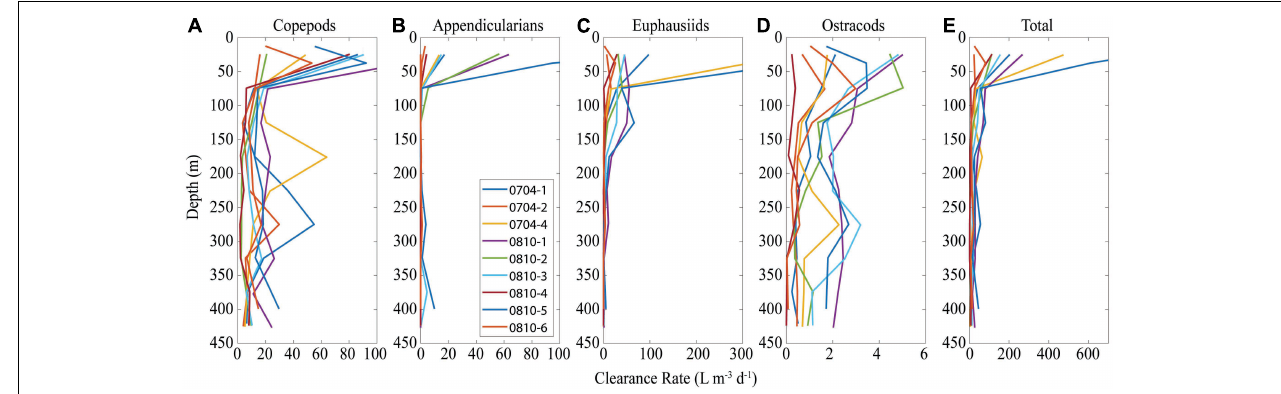
FIGURE 4 | Clearance rates for copepods (A) , appendicularians (B) , euphausiids (C) , ostracods (D) , and the sum of all four groups (E) . Each plot shows results within 50-m bins as collected by MOCNESS tows and computed using Eq. 8.